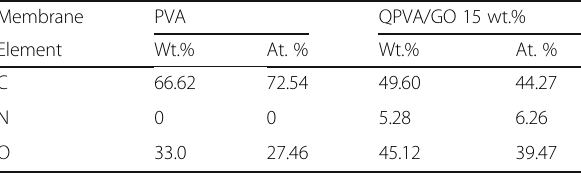
Table 1 The results of element mapping of the PVA membrane and QPVA/GO 15 wt.% composite membrane Membrane